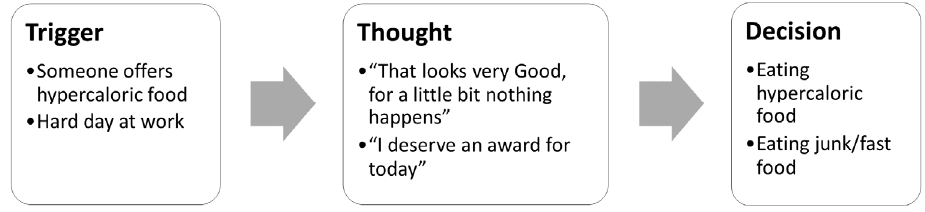
Figure 1. Examples of the consequences of sabotaging thoughts for a weight loss patient .